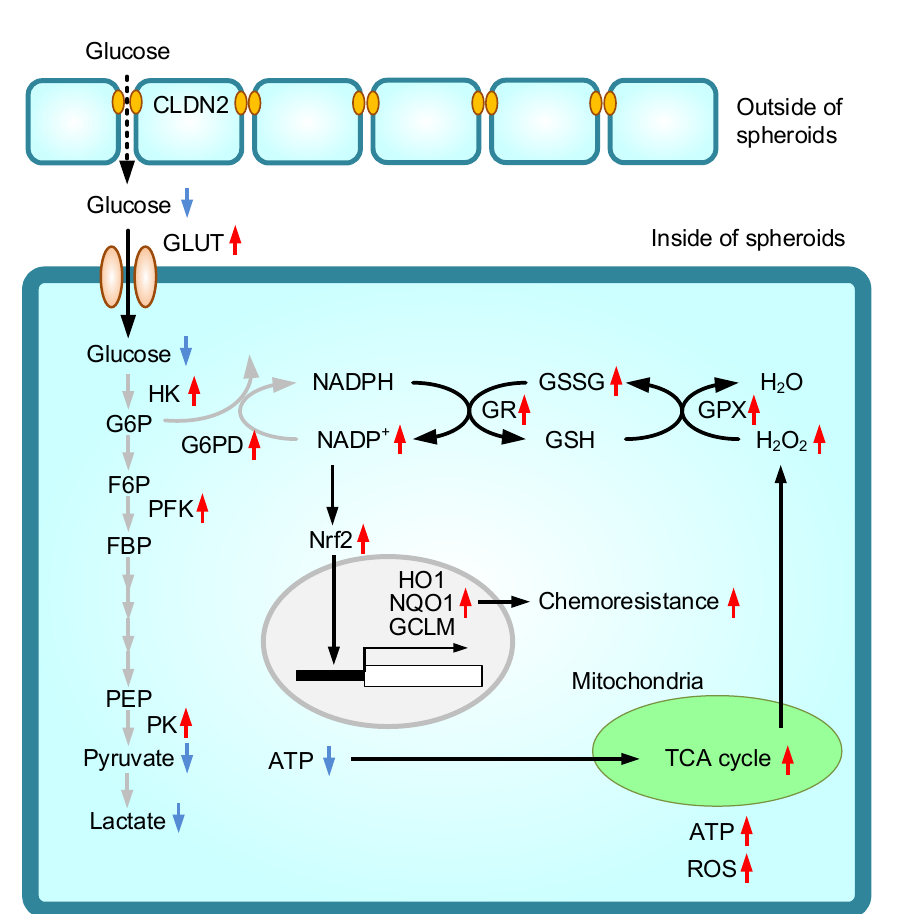
Figure 9. A putative model of CLDN2 ‐ induced Nrf2 signal. The cells expressing CLDN2 in the outside of spheroids block the paracellular influx of glucose. Glucose deprivation enhances the expression of glucose transporters and glucose metabolic enzymes. The reduction of glycolytic ATP production promotes the activation of mitochondrial energy metabolism and ROS generation. The oxidative stress confers chemoresistance mediated by the activation of the Nrf2 signal.